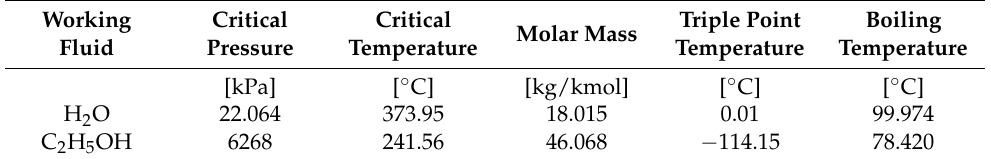
Figure 3. Capillary pressure rise characteristic for ethanol as a working fluid. Table 1. Comparison of the basic physical properties of water (H 2 O) and ethanol (C 2 H 5 OH).